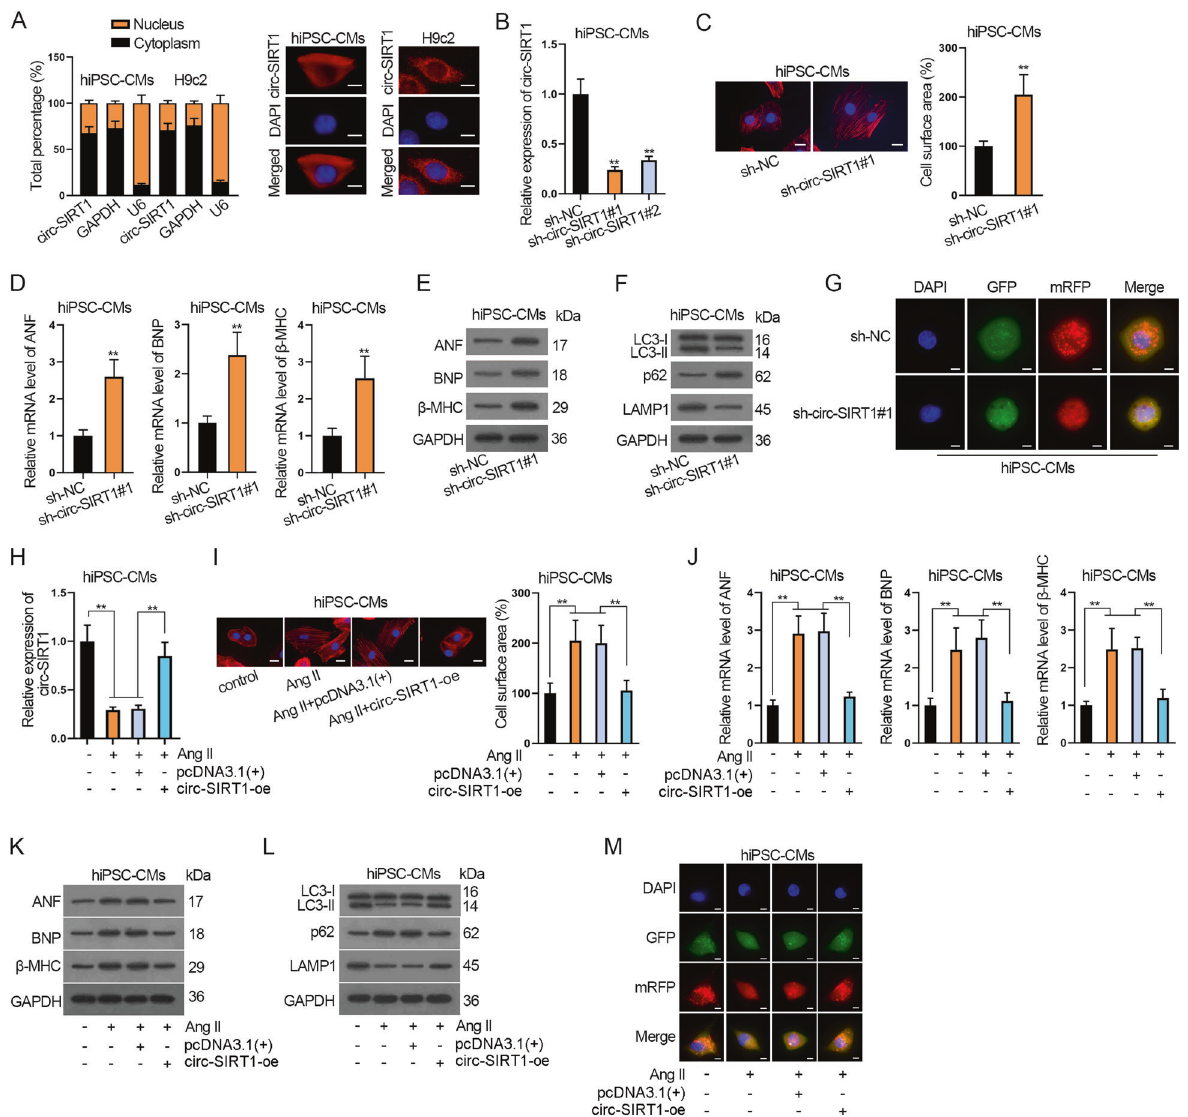
Fig. 2 Circ-SIRT1 inhibits CH and contributes to autophagy in hiPSC-MCs. A The subcellular distribution of SIRT1 (or Sirt1) was detected via subcellular fractionation and FISH assays. Scale bar, 10 μ m. N = 3. B RT-qPCR analysis of circ-SIRT1 knockdown by sh-circ-SIRT#1/2 in hiPSC- CMs is shown. N = 3. C Analysis of the effects of circ-SIRT1 de fi ciency on cell surface area via immuno fl uorescence staining. Scale bar, 10 μ m. N = 3. The percentage of cell surface area of the sh-circ-SIRT1#1 group to that of the sh-NC group was evaluated. D , E The expressions of CH markers in hiPSC-CMs transfected with sh-NC or sh-circ-SIRT1#1 were examined via RT-qPCR and western blot analyses. F Western blot analysis of levels of autophagy-related proteins (LC3-II/LC3-I, p62, and LAMP1) in hiPSC-CMs transfected with sh-NC or sh-circ-SIRT1#1. N = 3. G The hiPSC-CMs were transfected with Ad-GFP-mRFP-LC3 for 48 h and sh-NC or sh-circ-SIRT1#1. The change of both GFP fl uorescence (green) and mRFP (red) fl uorescence was observed by confocal microscopy. Scale bar, 10 μ m. N = 3. H Circ-SIRT1 expression in hiPSC-CMs treated without or with Ang II and transfected with pcDNA3.1( + ) or pcDNA3.1( + )/circ-SIRT1 (circ-SIRT1-oe) was examined via RT-qPCR. N = 3. I Cell surface area of hiPCS-CMs treated without or with Ang II and transfected with pcDNA3.1( + ) or pcDNA3.1( + )/circ-SIRT1 (circ-SIRT1-oe) was analyzed by immuno fl uorescence staining. Scale bar, 10 μ m. N = 3. J , K The expression of CH markers in hiPSC-CMs of the above-mentioned groups was examined via RT-qPCR and western blot analyses. N = 3. L , M The effect of upregulated circ-SIRT1 on autophagy in fl ux in hiPSC- CMs treated without or with Ang II and transfected with pcDNA3.1( + ) or pcDNA3.1( + )/circ-SIRT1 (circ-SIRT1-oe) was analyzed via western blot analysis of autophagy-related proteins and immuno fl uorescence staining analysis of Ad-GFP-mRFP-LC3. Representative images of GFP dots (green), mRFP dots (red), and their merged images are shown. Scale bar, 10 μ m. N = 3. ** P < 0.01 was assessed by Student ’ s t test for comparison between groups, one-way ANOVA and Tukey for multiple notably elevated mRNA and protein levels of ANF, BNP, and knockdown ef fi ciency, we used these shRNAs for functional β -MHC, indicating that circ-SIRT1 de fi ciency was conducive to CH experiments. formation (Fig. 2D, E and Supplementary Fig. 1G). Next, CH was determined by measuring cell surface area, Autophagy is known to be crucial to CH development [16, 31], sarcomere organization, and CH markers. Consequently, circ-SIRT1 and SIRT1 (or Sirt1), the associated gene for circ-SIRT1 (or circ-Sirt1), silencing observably enlarged cell surface area and increased the has been proved to regulate autophagy in CH [14, 15]. Therefore, we ratio of well-organized cardiomyocytes of hiPSC-CMs (Fig. 2C and evaluated autophagic fl ux in Ang II-treated hiPSC-CMs. Western blot Supplementary Fig. 1F). In addition, knockdown of circ-SIRT1